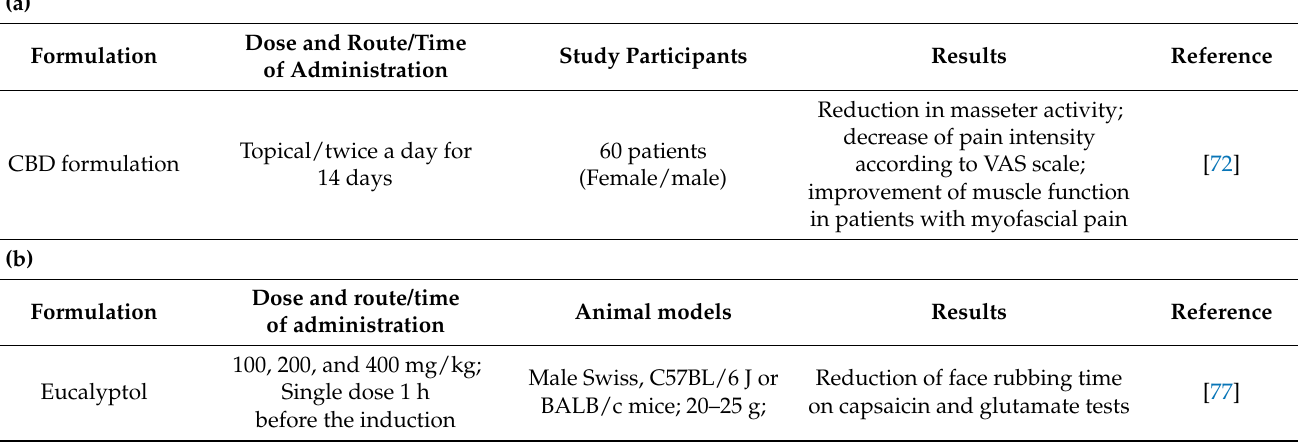
Table 1. An overview of the included studies’ characteristics using natural compounds: in panel ( a ) the studies conducted on humans and ( b ) those on animal models are